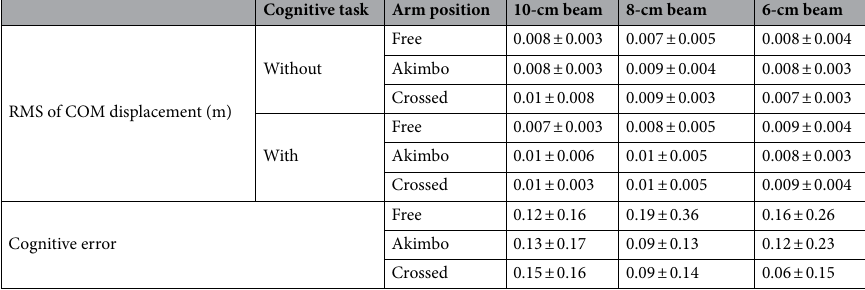
Table 2. Mean and standard deviation (±) of the root mean square (RMS) of center of mass (COM) displacement and cognitive error for all beam width and arm position conditions.